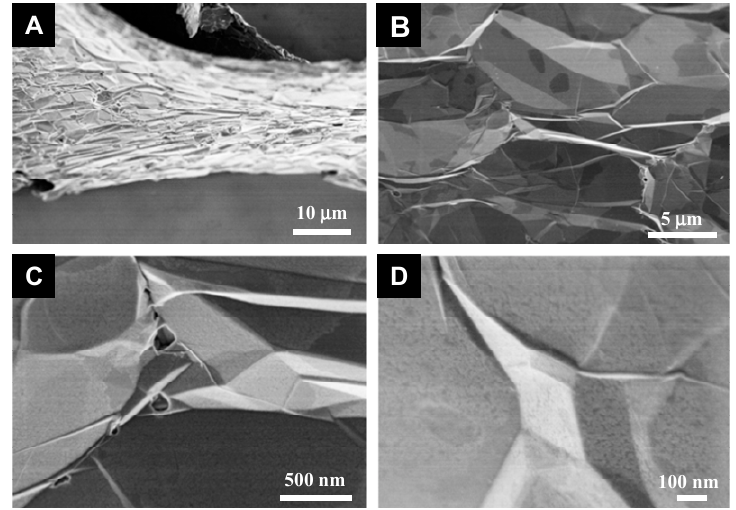
Fig. 1 SEM images of 3D graphene with different magnifications.